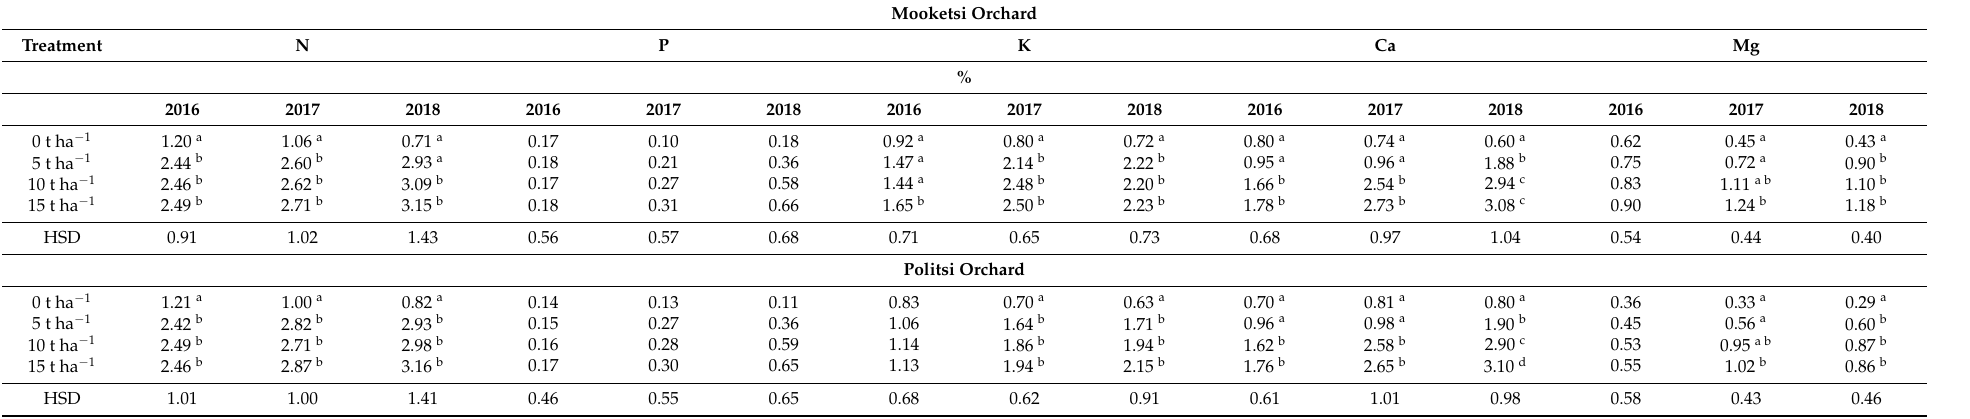
Table 3. Leaf macronutrients (N, P, K, Ca, and Mg) contents as influenced by compost application rates over a three-year study (2016–2018) at Mooketsi and Politsi orchards.